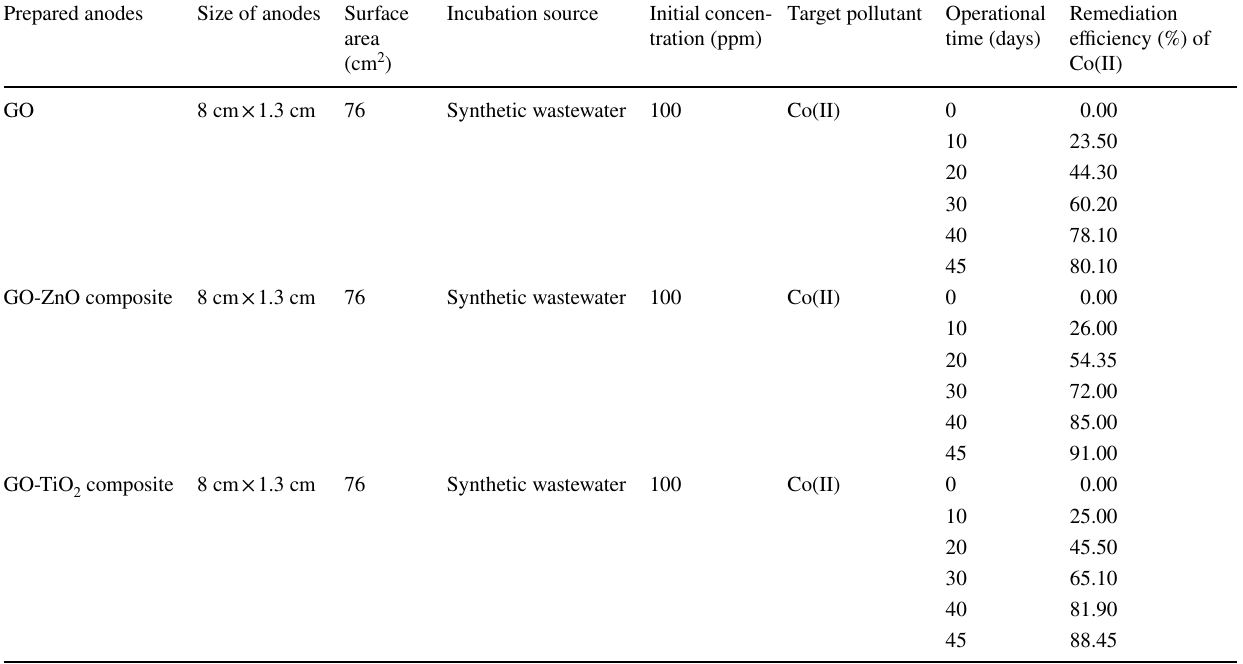
Table 4 Trend of remediation efficiency of Co(II) in present study Prepared